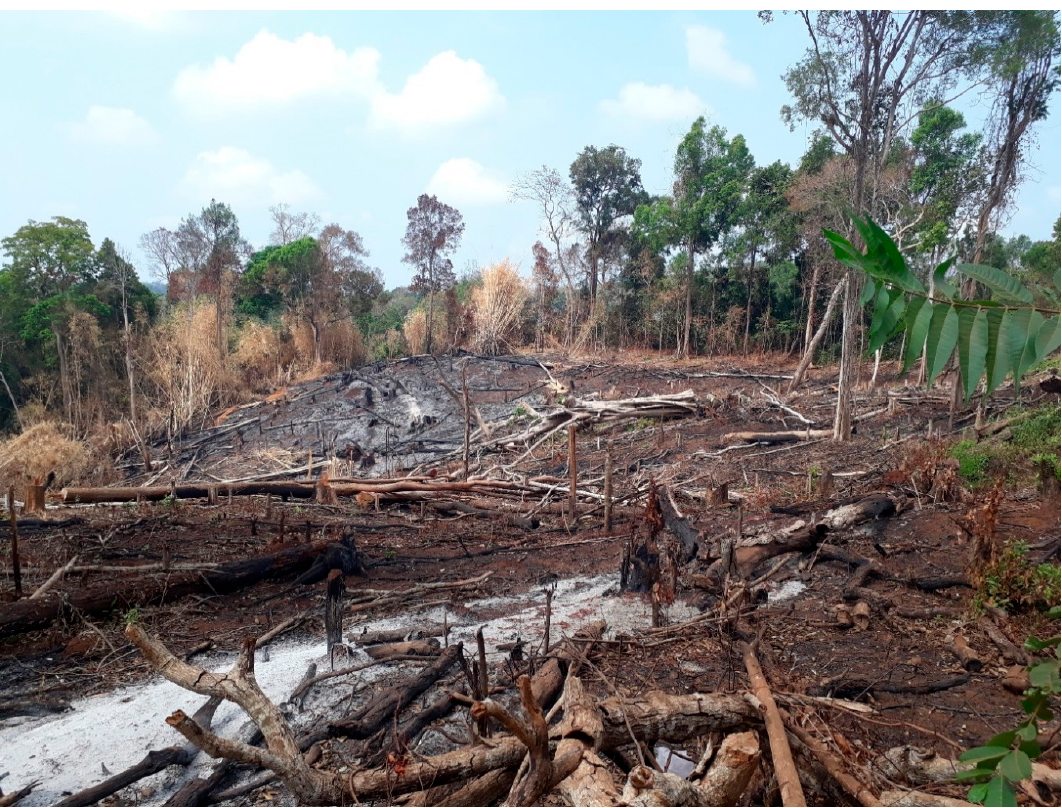
Figure 1. Forest recently cut down and burnt to clear space for agriculture, by using the “slash and burn” method, Kaev Seima district, Mondulkiri Province, Cambodia (photo: A.P.).